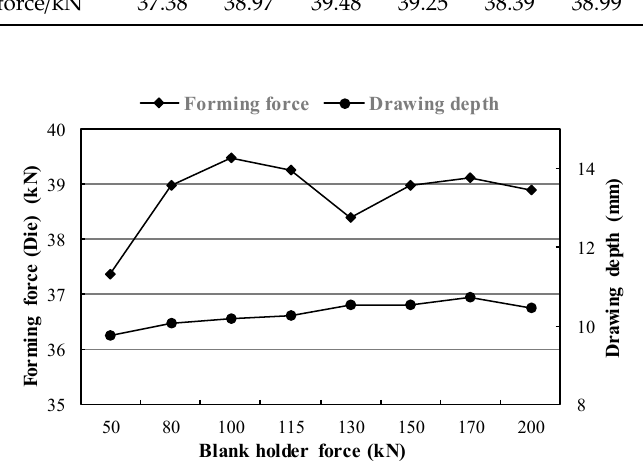
Figure 11. Data analysis on the tests of hemispherical part drawing.